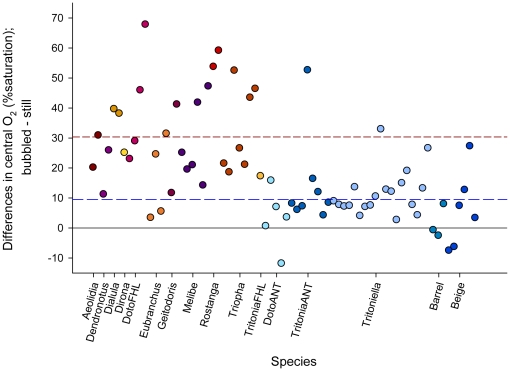
Effects of bubbling on central O2 in temperate vs. Antarctic masses.Each point represents the difference between central O2 equilibrated under bubbled, air saturated conditions, and central O2 measured in the same mass equilibrated in still water. The solid black line is the line of no difference; almost all masses, therefore, had higher central O2 under bubbled conditions than in still water. The blue dotted line is the mean difference for Antarctic masses, which is ∼20% lower than the mean difference for temperate masses (red dotted line).